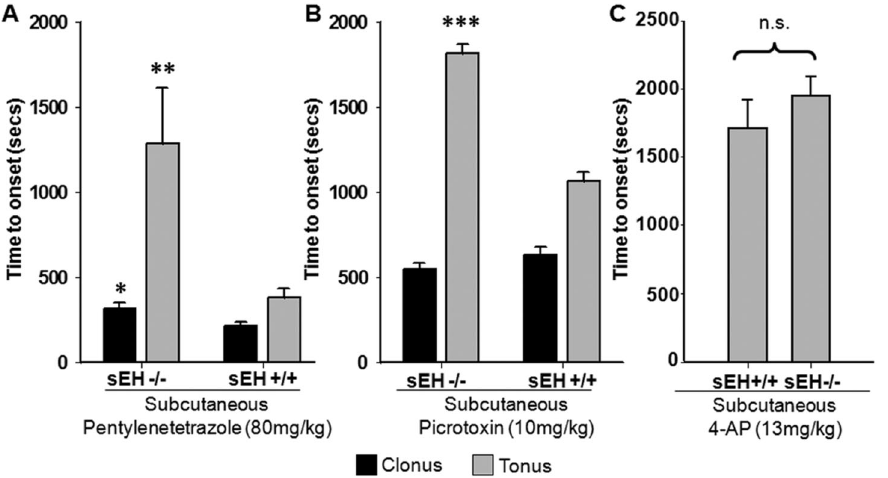
Figure 1. Genetic deletion of sEH delays seizure onset induced by GABA antagonists. Deletion of the sEH gene in mice stabilizes EETs and delays onset of seizures induced by pentylenetetrazole (PTZ) and picrotoxin (PIC). ( A ) Subcutaneous PTZ led to a set of stereotypical convulsive behaviors including myoclonic (black bars) and tonic (gray bars) seizures in mice. In sEH 2 / 2 mice both clonic and tonic phase of seizures were delayed compared to conspecific C57/BL6 mice (n=6 mice/group, Student’s t -test, sEH 2 / 2 vs. wt, * p=0.049 and ** p=0.001). Note that animals that did not display tonic hind limb extension reflex within 30 min were excluded from these graphs (see Table 1 for survival data). ( B ) Onset of tonic seizures induced by subcutaneous PIC were delayed in sEH 2 / 2 mice (n=5 mice/group, Student’s t -test, sEH 2 / 2 vs. wt, ***p=0.003), while onset of PIC induced clonic seizures did not differ (p=0.75). ( C ) Seizures induced by 4-AP led to tonic seizure without a clear clonic phase and onset in sEH 2 / 2 and wt mice were not significantly different (n=7/group, p=0.39). Data are expressed as mean 6 s.e.m for all figures. Table 1. Time to onset of clonic seizure was not affected by inhibition of sEH ( Fig. 2A ). In parallel to the observations with sEH 2 / 2 mice tonic seizures induced by 4-AP were not different between vehicle and TUPS treated mice, though the Swiss mice were more sensitive to 4-AP ( Fig. 2C ). In low dose groups sEHI significantly delayed the onset of seizures, though at higher doses efficacy was lower. Nevertheless, mice treated with TUPS were protected from tonic seizures in a linear and dose dependent manner ( Table 1 ). Compared to an effective dose of diazepam which prevented clonic seizures in 50% and tonic seizures in 100% of the mice, TUPS protected 44% of the mice from tonic hind limb extension ( Table 1 ). Unlike the sEH 2 / 2 mice, tonic hind limb extension was a consistent phenotype in animals pretreated with both sEHI.